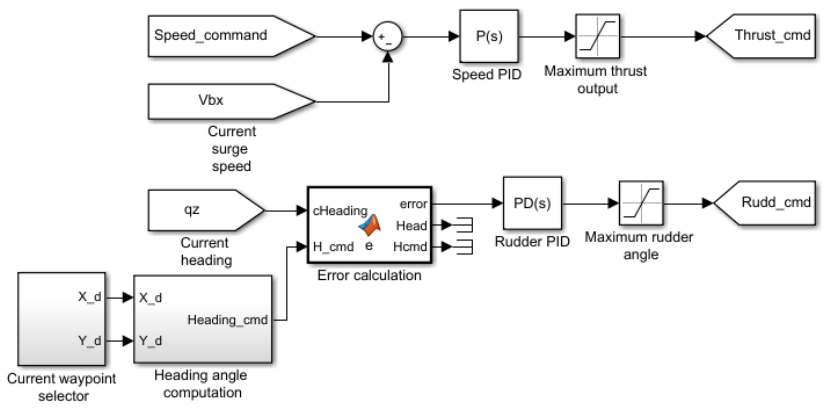
Figure 9. StriderV1.0 controllers block diagram in